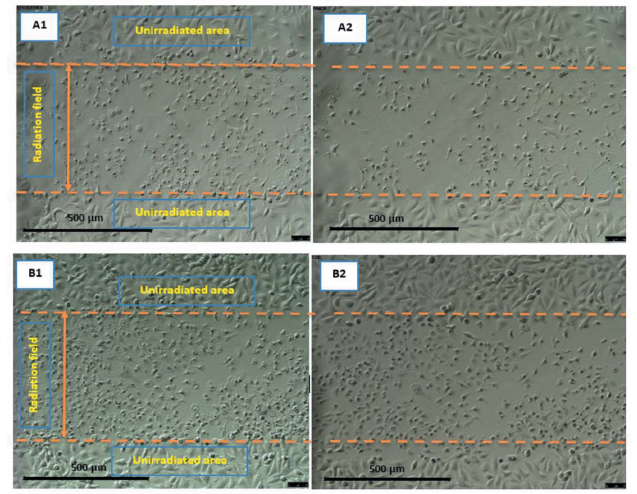
Figure 9 Human lung A549 cancer cells irradiated with 1000 Gy SBB. The radiation field is marked by orange dotted lines. (A1) Control (no AuNPs) 24 h, (A2) control (no AuNPs) 48 h, (B1) treated group (with 1 m M AuNPs) 24 h and (B2) treated group (with 1 m M AuNPs) 48 h post-irradiation with PBS wash.